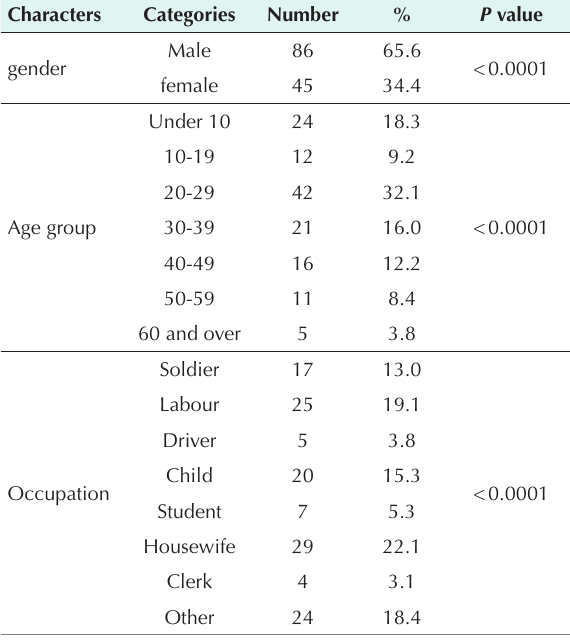
Table 2. The Characteristics of People With Cutaneous Leishmaniasis From 2014 to 2019 in Izeh County